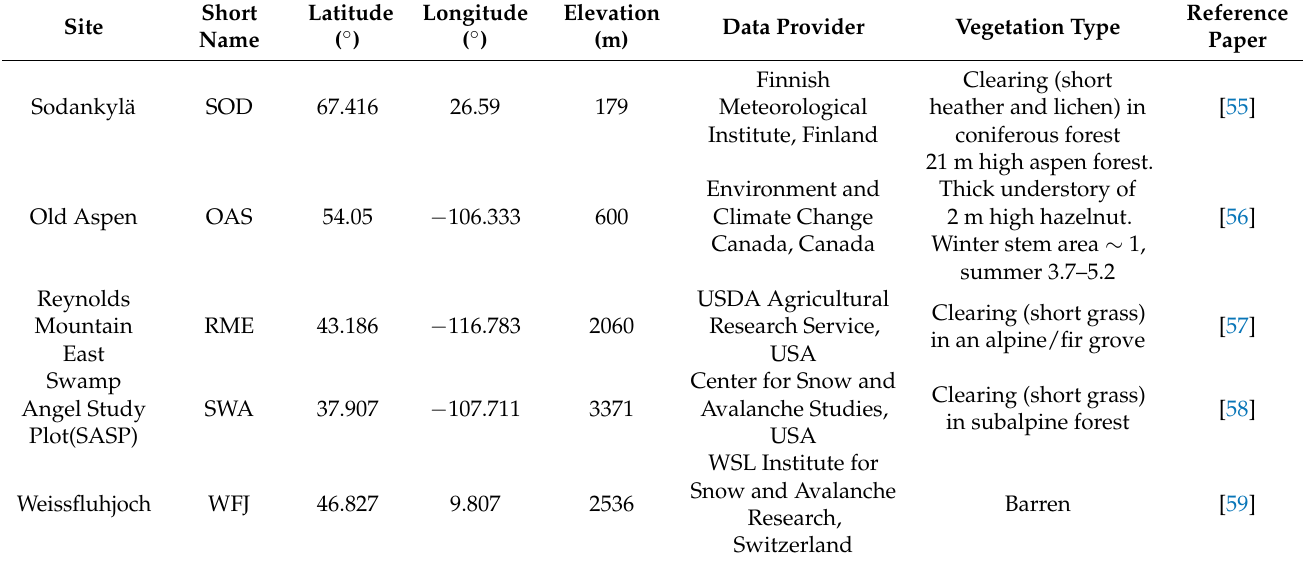
Table A2. Data ownership and reference papers for five independent snow observations sites (Modified by M é nard et al. [61]). Site